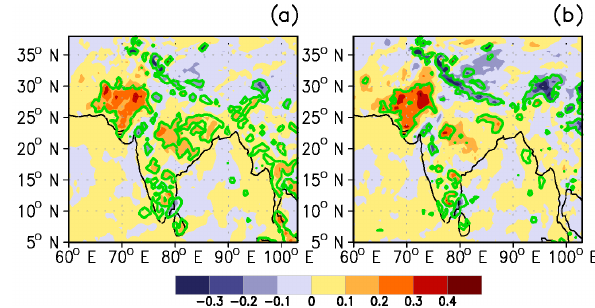
Figure 7. Difference (PLC–HLC) in (a) number of moderate rain- fall events during JJAS and (b) total amount of moderate rainfall (in mmday − 1 ; 1982–2008). Green contour shows differences signifi- cant at the 90% confidence level.